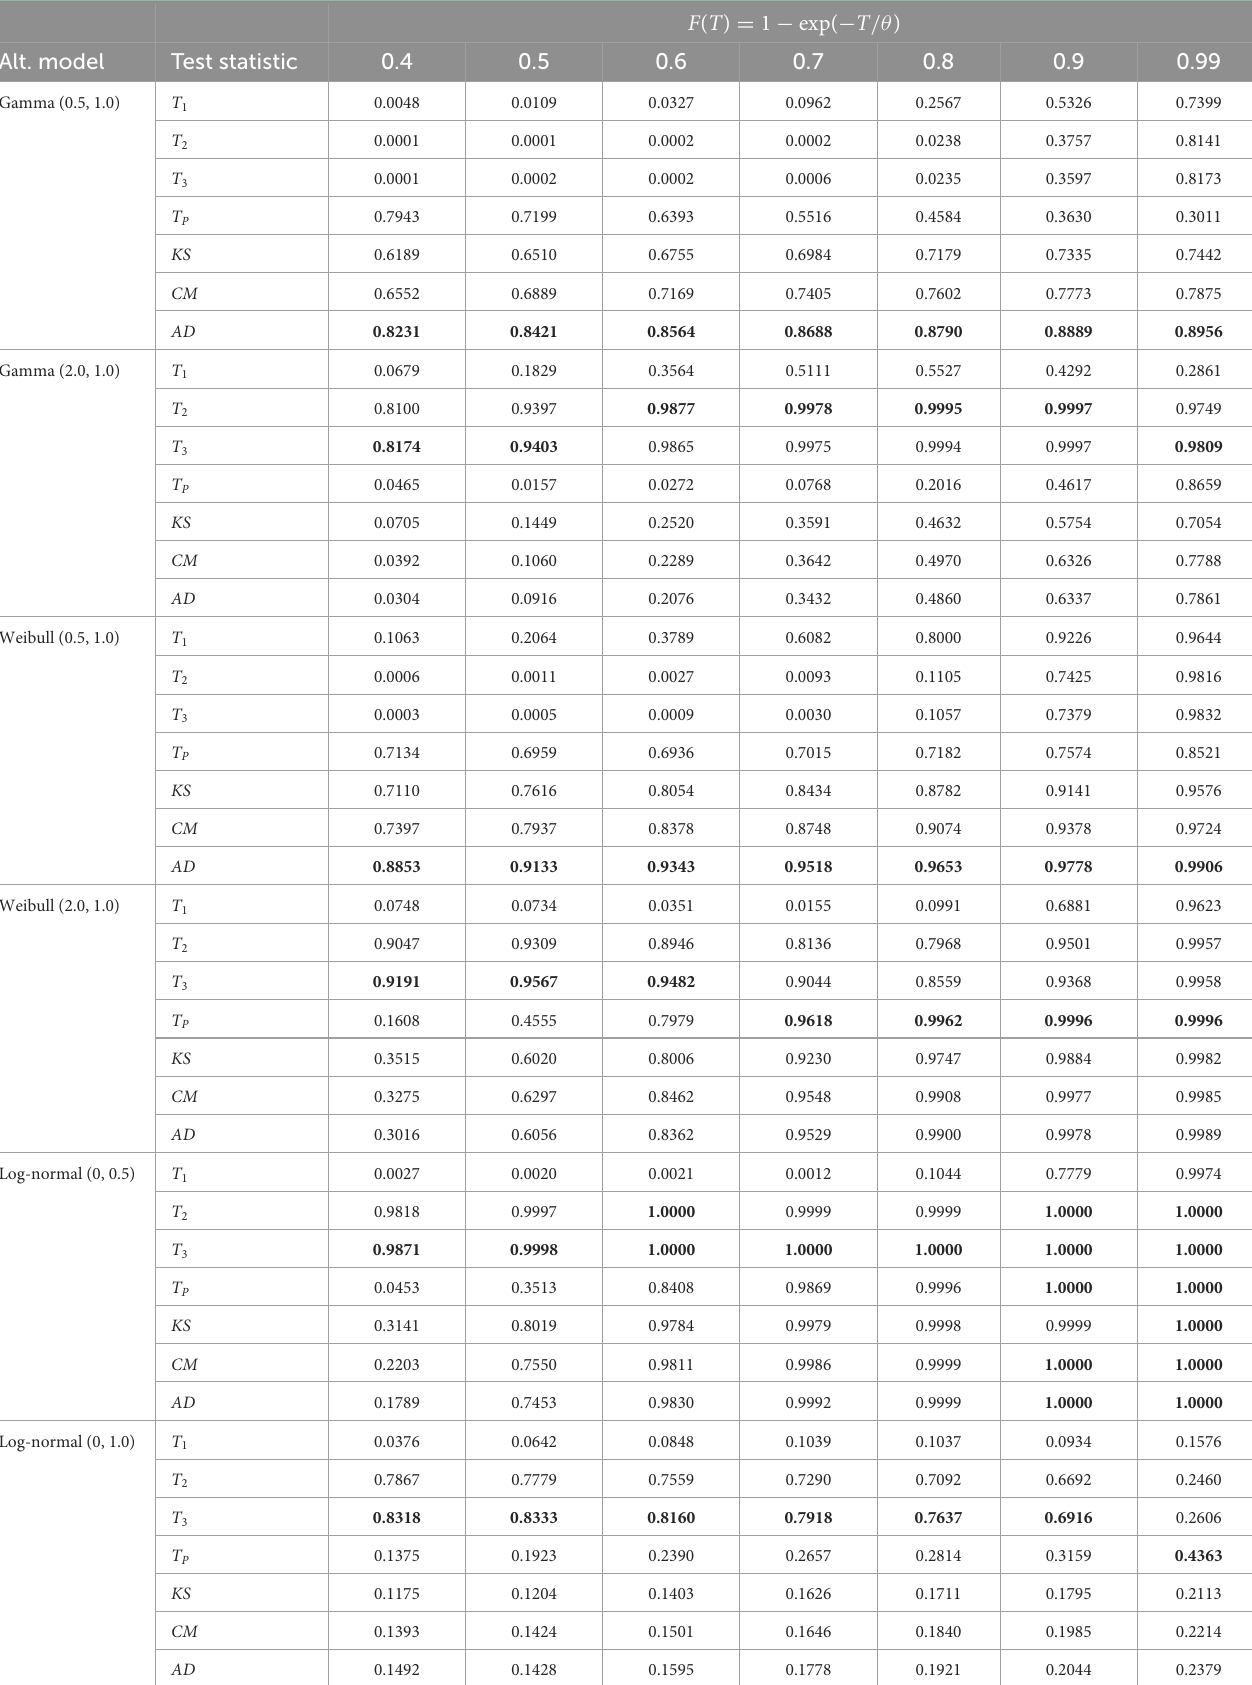
30, α 0.10 and 10 5 = =